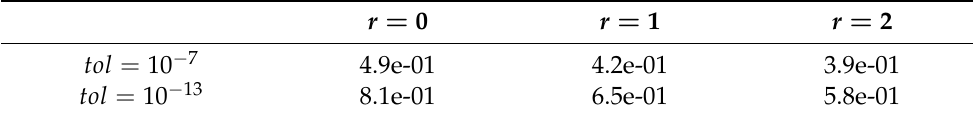
Table 2. CPU time to calculate (6) for the data in Section 2.1 using formula (19) and subroutine phipm.m just for the last